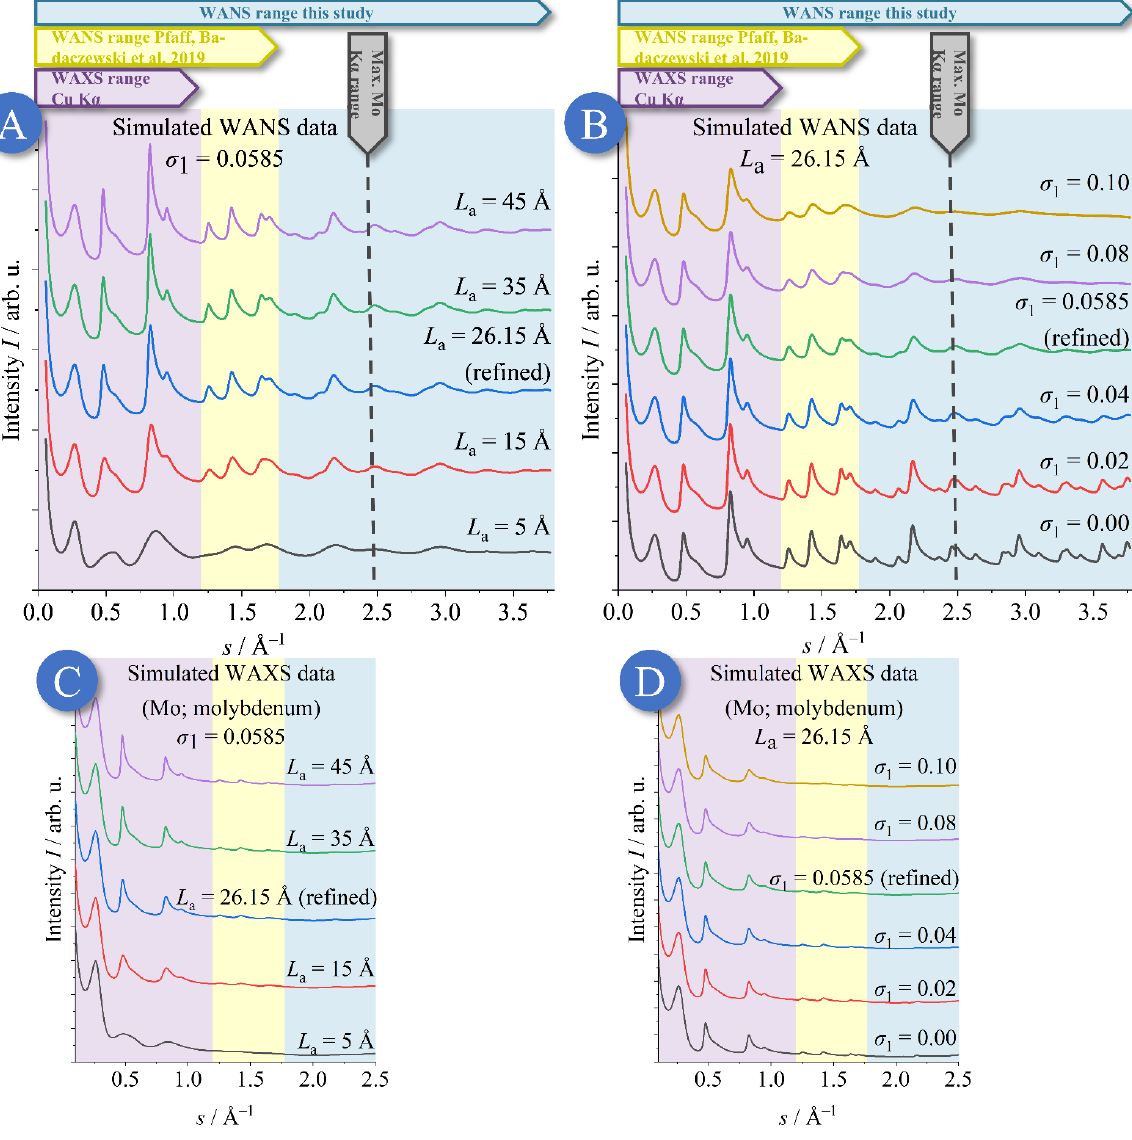
Figure 14. ( A – D ) : Simulation of WANS and WAXS curves to assess the respective impact of different values of L a and σ 1 with regard to the fundamental question as to whether size ( L a ) and disorder/strain ( σ 1 ) can be validly disentangled at all. The refined values for PF-R 1800 were used to simulate scattering curves with higher/lower layer extension/order. ( A ): simulated WANS data ( λ = 0.4975 Å) with constant σ 1 and variation of L a . ( B ): simulated WANS data ( λ = 0.4975 Å) with constant L a and variation of σ 1 assuming typical values of σ 1. The layer disorder ( σ 1 ) as well as the layer extension ( L a ) were overestimated in previous WAXS studies, as the s -range was insufficient. By using WANS data presented here in this study, it is possible to differentiate between these parameters in their impact on the data and to quantify them reliably. Building on this leads to a new view of the NGCs, especially the resins: The graphene layers were much smaller but more ordered, as assumed before. ( C , D ): simulated WAXS curves using Mo-K α radiation ( λ = 0.71 Å), under variation of L a and σ 1 , analogue to ( A ) and ( B ). Using Mo-K α radiation ( λ = 0.71 Å) allows for WAXS data with a high s -range, but suffers from the damping of the atomic form factor, so the visible reflections will have only a low intensity. Hence, size ( L a ) and disorder ( σ 1 ) cannot be precisely determined, even when using a Mo-K α radiation source. The measurement range of Pfaff et al. is related to reference [43].